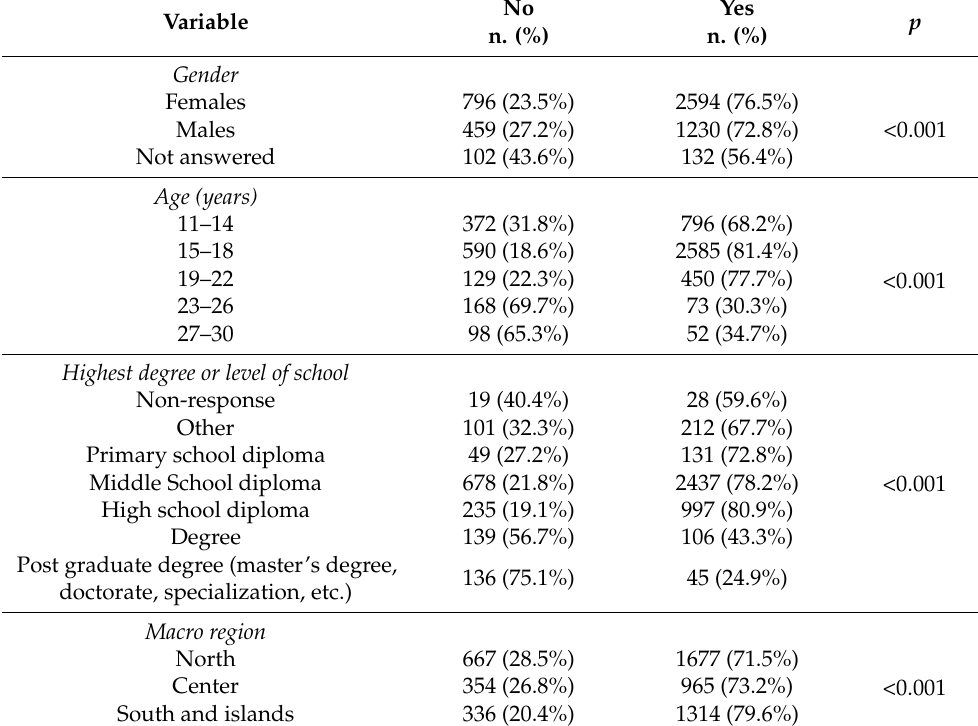
Table 3. Univariate analysis with dependent variable of willingness to be vaccinated against COVID-19.